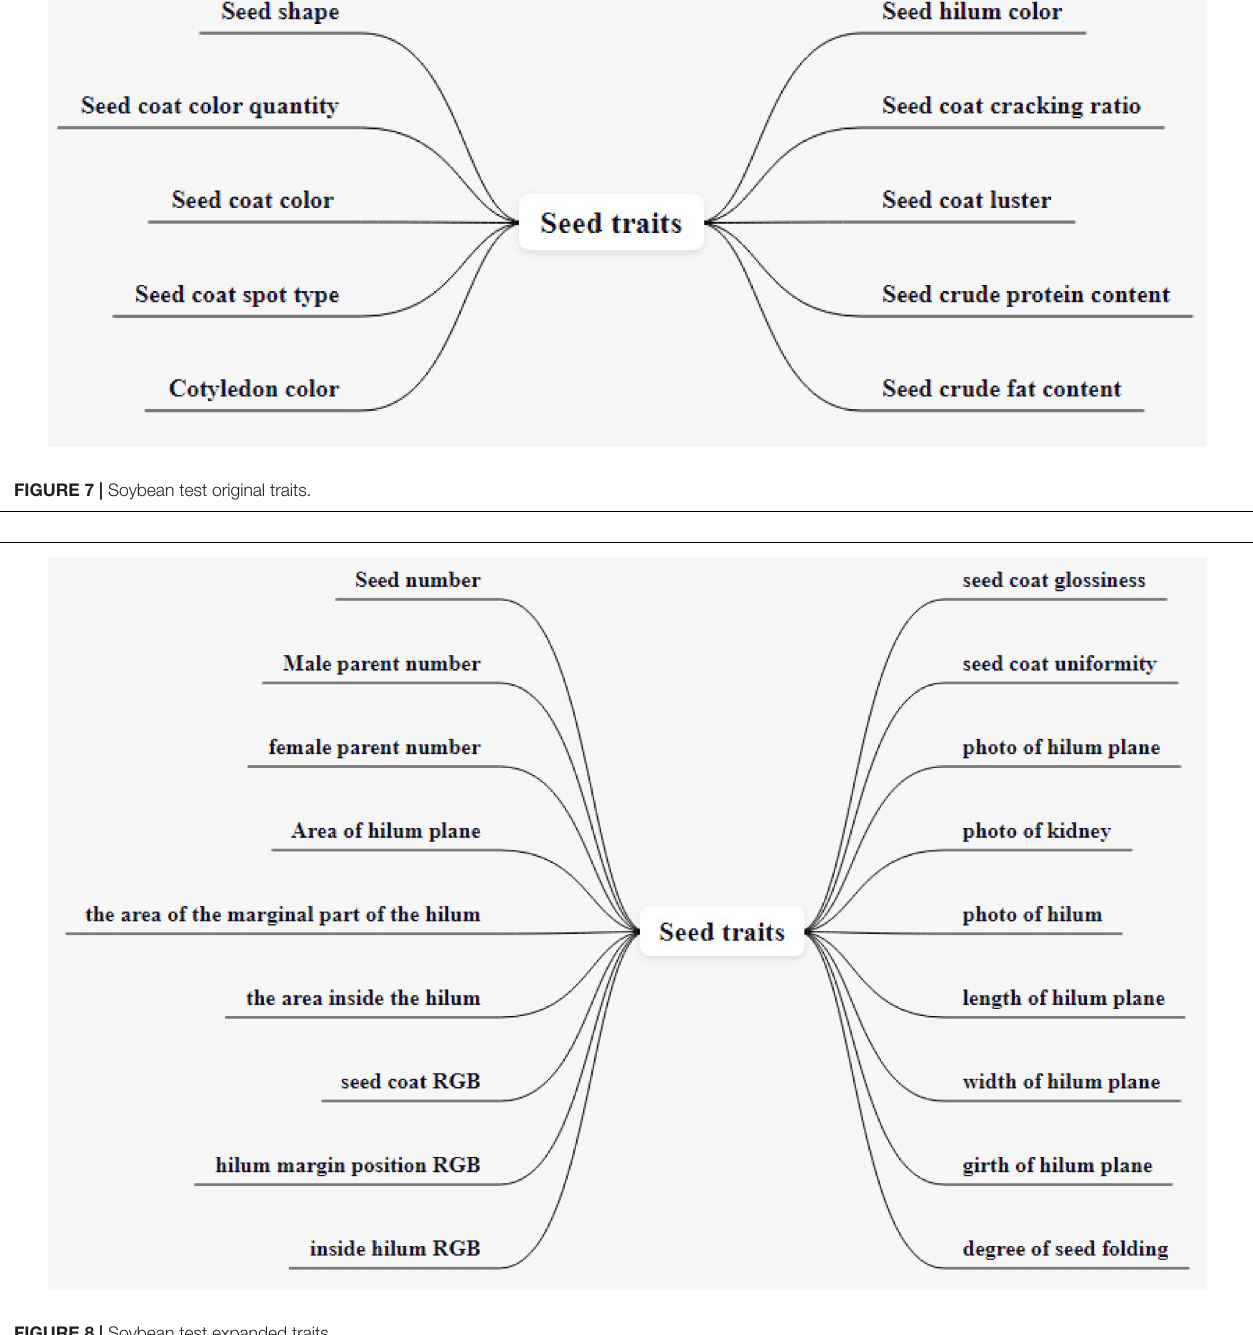
FIGURE 8 | Soybean test expanded